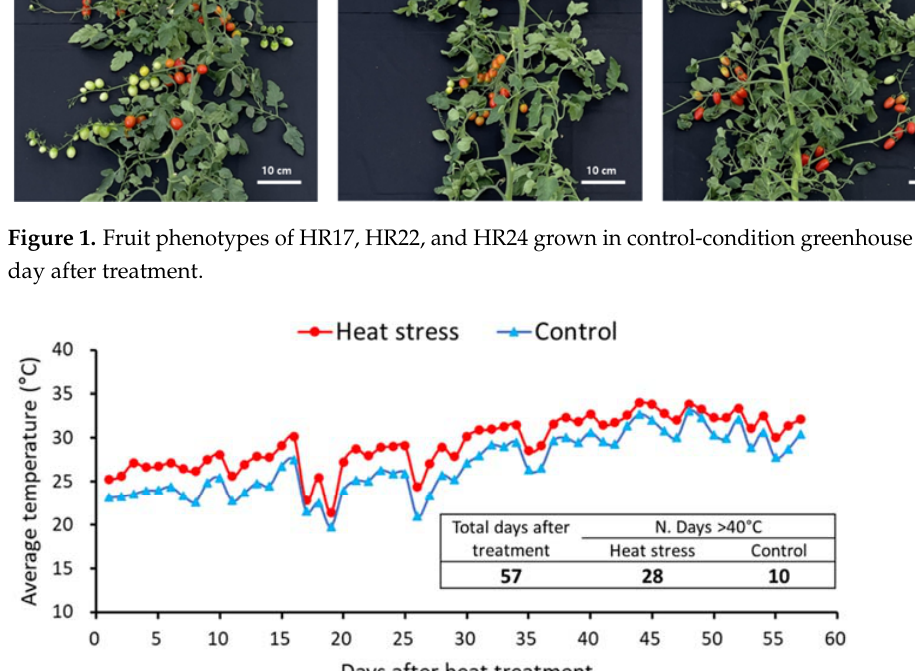
Figure 2. Average temperatures changes in heat-treated greenhouse and control greenhouse (Wanju, Republic of Korea). In table, the number of total treatment days, and the number of days when the daily maximum temperatures were over 40 ◦ C in both greenhouses were presented. The heat stress was exposed to plants when plants were grown for about 62 days after